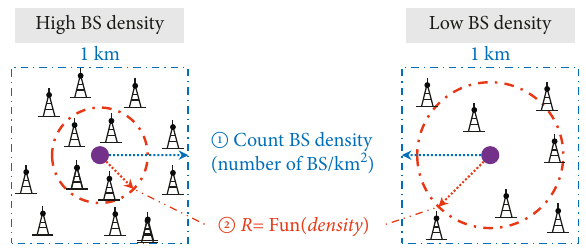
Figure 7: A diagram of adjusting CRs